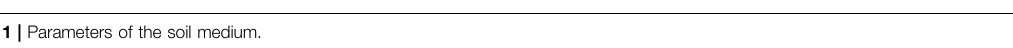
TABLE 1 | Parameters of the soil medium.